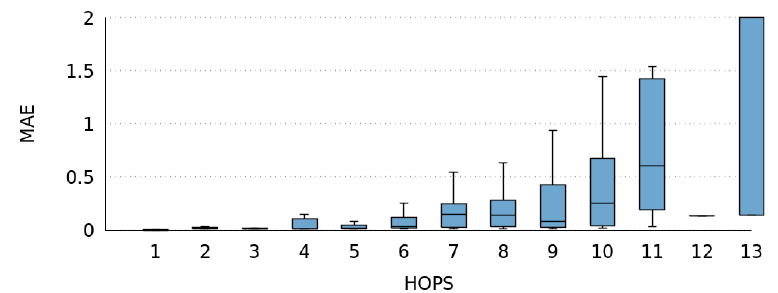
Figure 11. Distribution of the RBR Mean Absolute Error (MAE) as box plot.